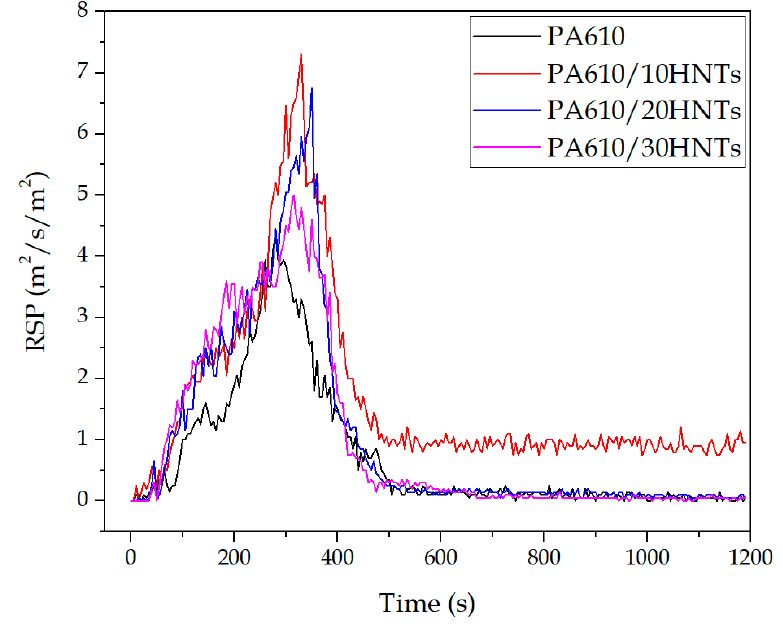
Figure 5. Smoke production rate of samples with HNTs.